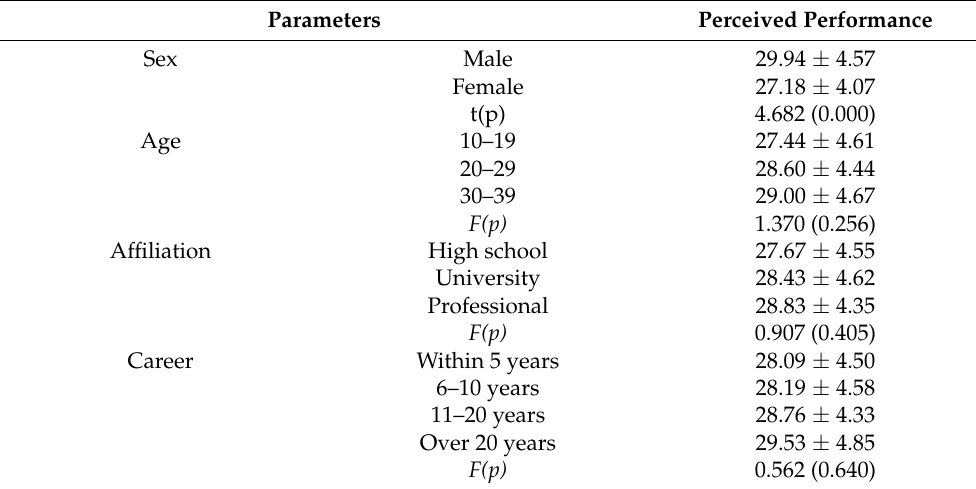
Table 4. Comparison of perceived performance ( n =